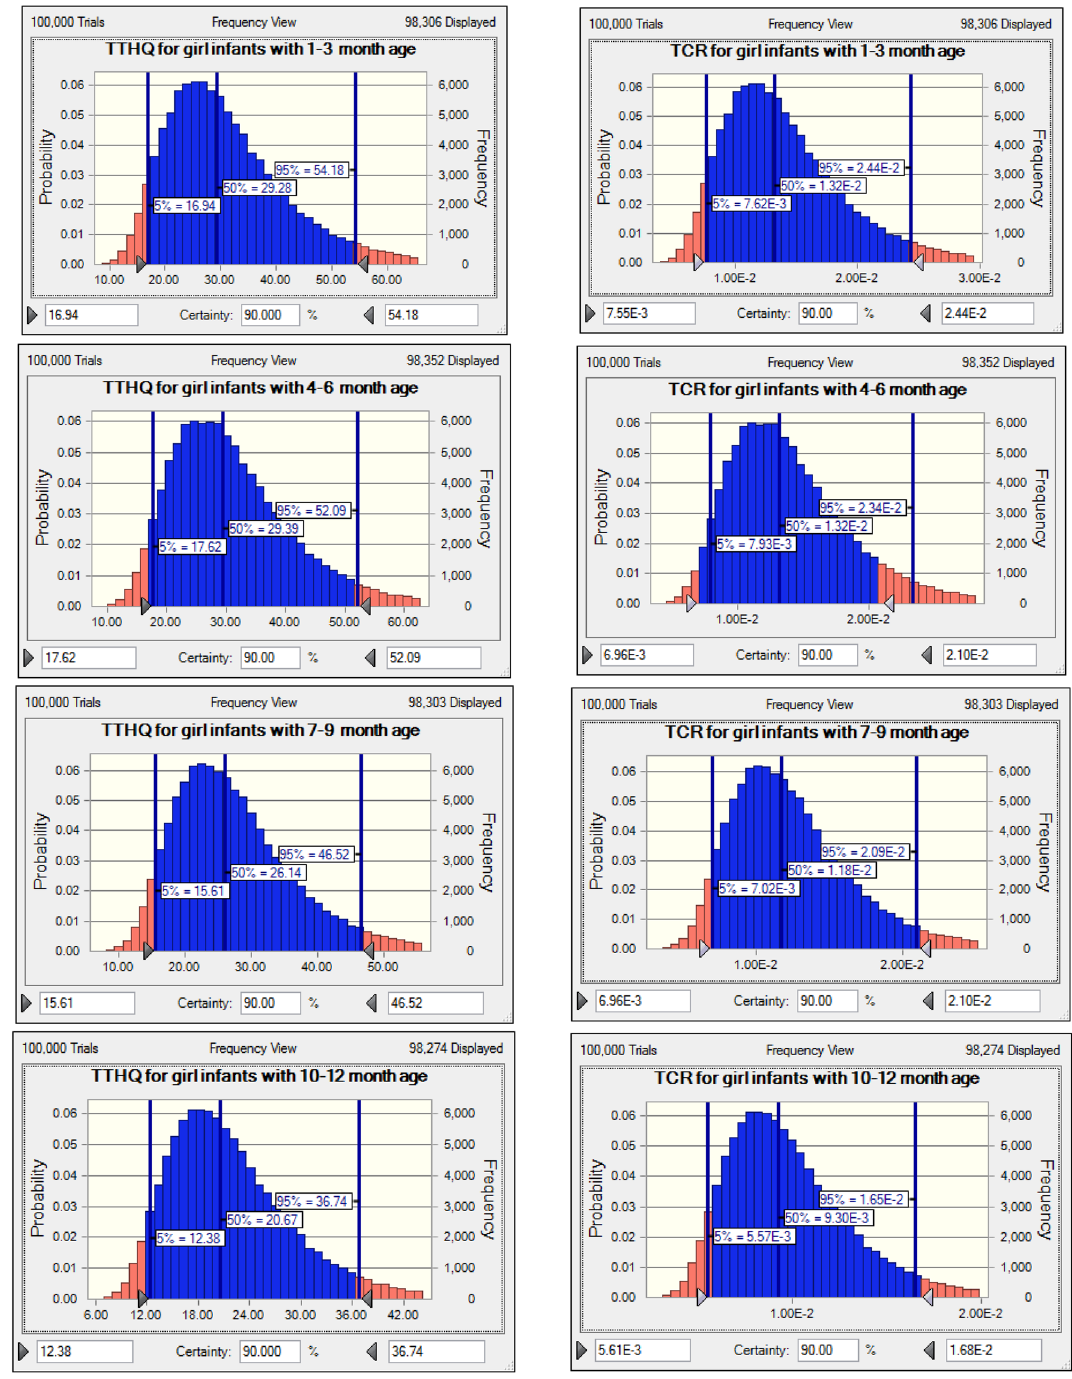
Figure 3. The uncertainty analysis of TTHQ and TCR related to toxic metals of breast milk for girl infants with different